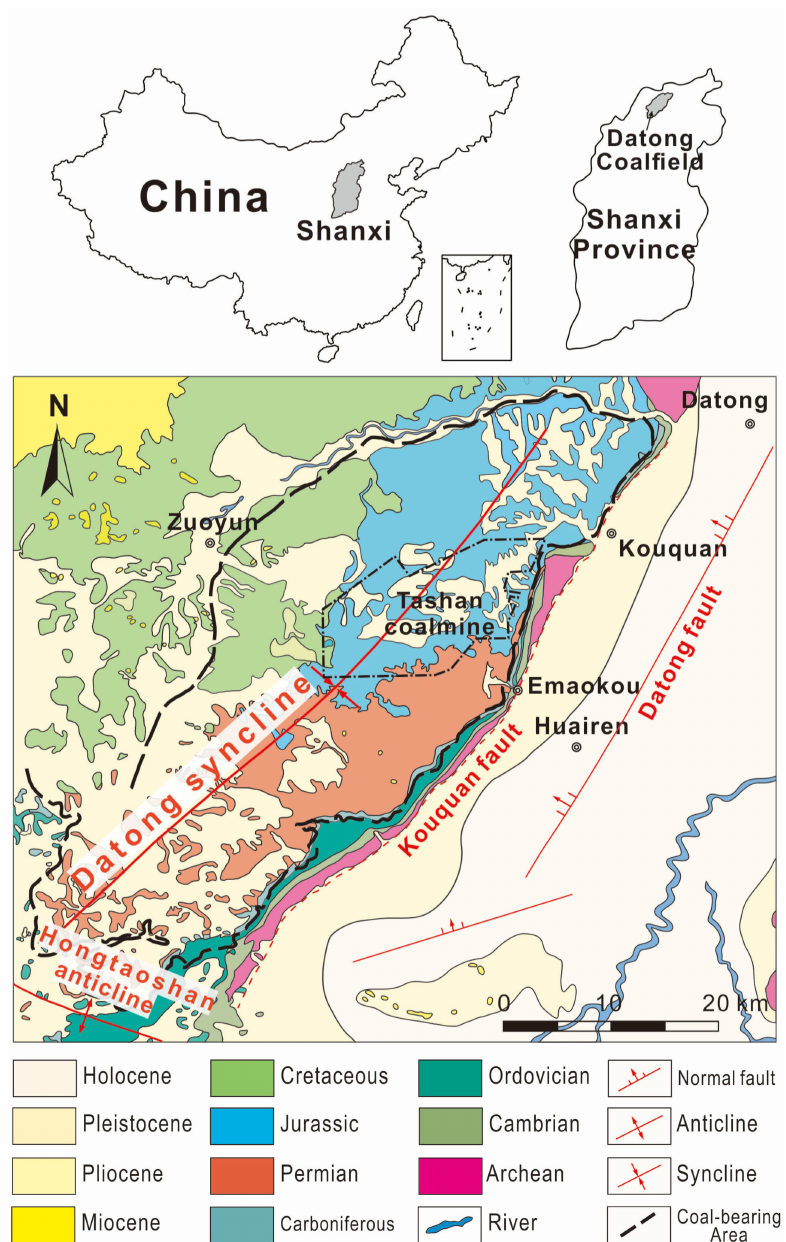
Figure 1. Geological map of the Datong coalfield and location of the Tashan Coal